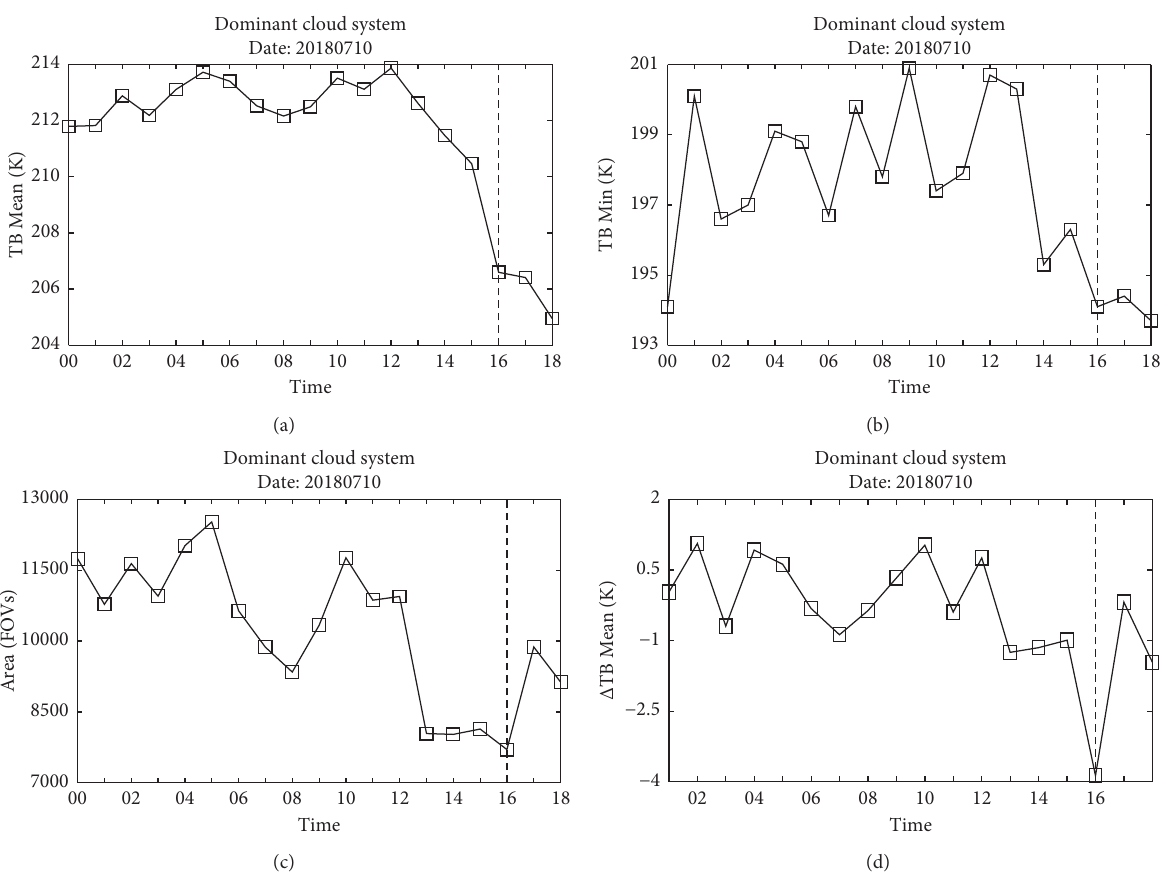
Figure 5: Temporal variation of radiation parameters (a, b), shape parameters (c), and gradient (d) of AGRI cloud